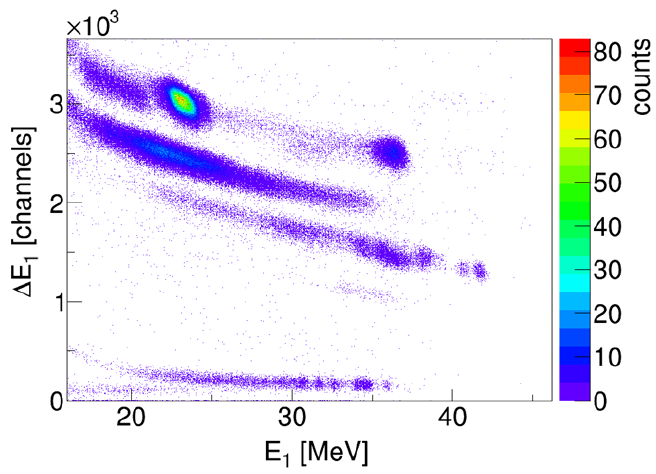
Figure 2. Δ E − E plot as seen in the telescope Δ E 1 − E 1